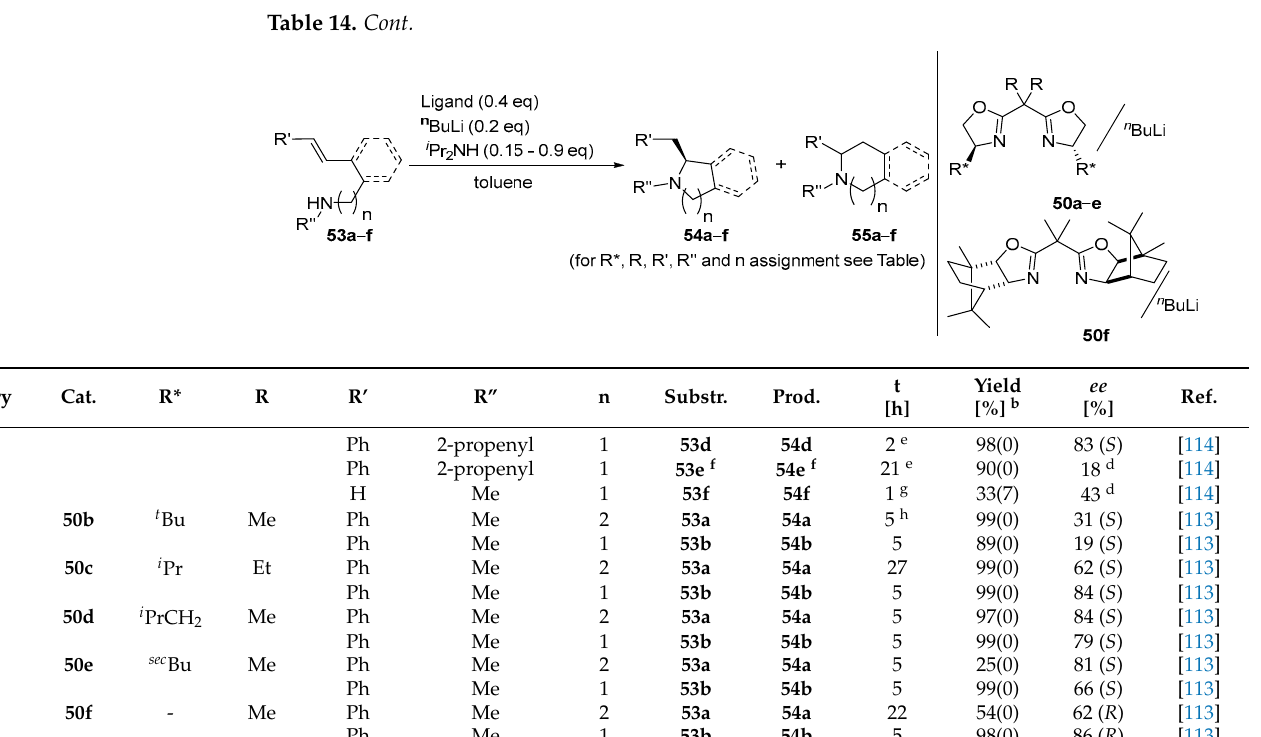
Table 14. Catalytic asymmetric hydroamination of 53a – f using chiral lithium catalysts 50a–f a . Table 14. Cont.